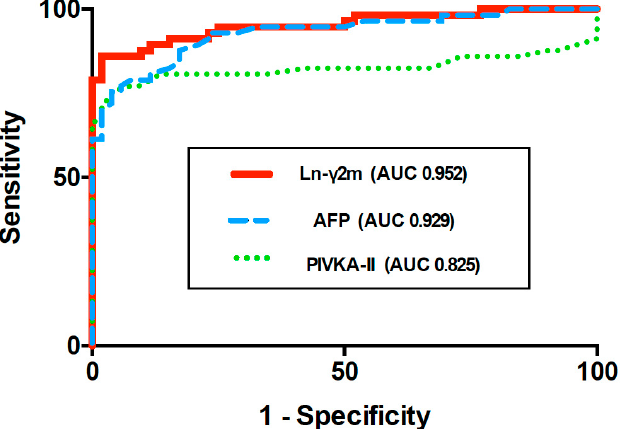
Figure 6. Scatter plot of Ln- γ 2 concentrations determined in serum samples from healthy subjects ( n = 52), patients with CLD ( n = 24), and patients with HCC ( n = 57). The optimal cutoff value for Ln- γ 2 to distinguish between HCC and non-malignant CLD is 116.6 pg/mL. Figure 6 is modified from Kiyokawa et al. [22].